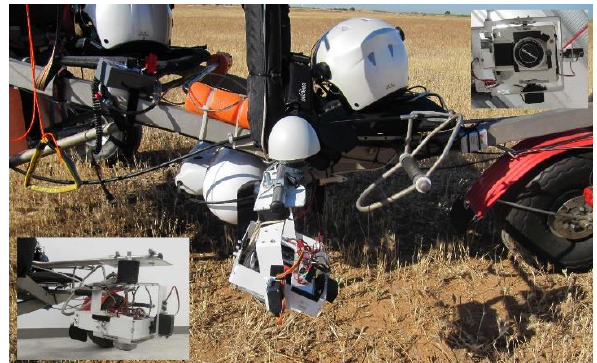
Figure 1: Aerial trike and MUSAS platform used in this study; top-right and bottom-left corner: detail of the gyrostabilized platform for the installation of sensors.